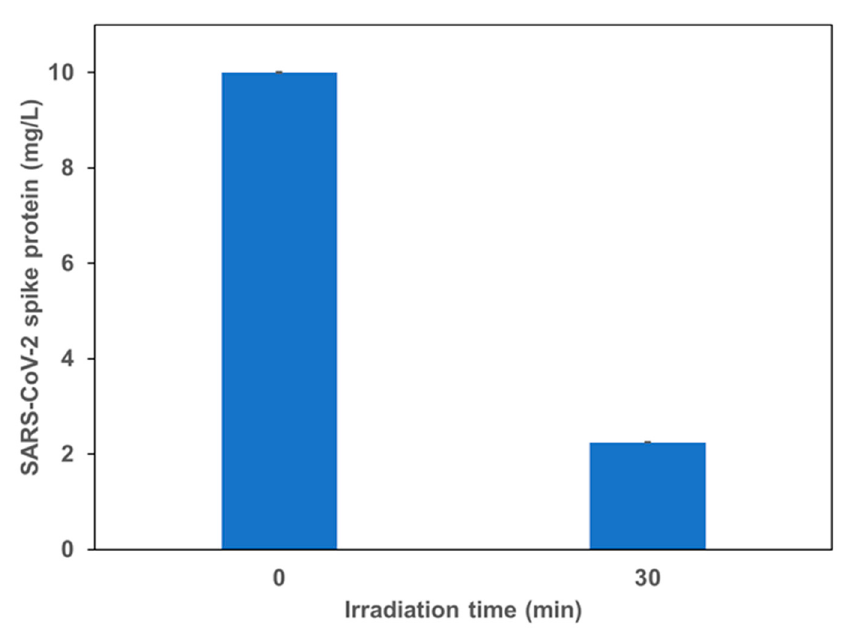
Figure 4. UV-vis absorption spectra of BSA: Dark experiment ( a , b ) and Royal blue LED irradiation ( c , d ).